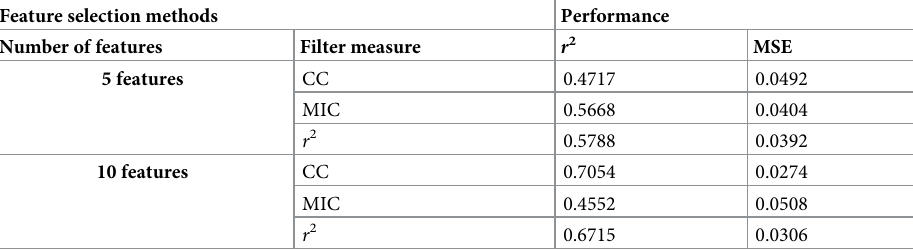
Table 7. Performances for SVR models built by filter approach.